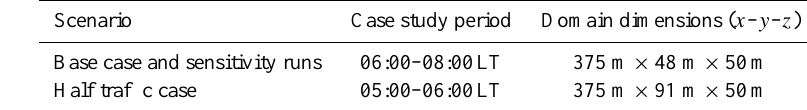
Table 2. Domain sizes for near-road dispersion simulations under different traffic flow conditions.